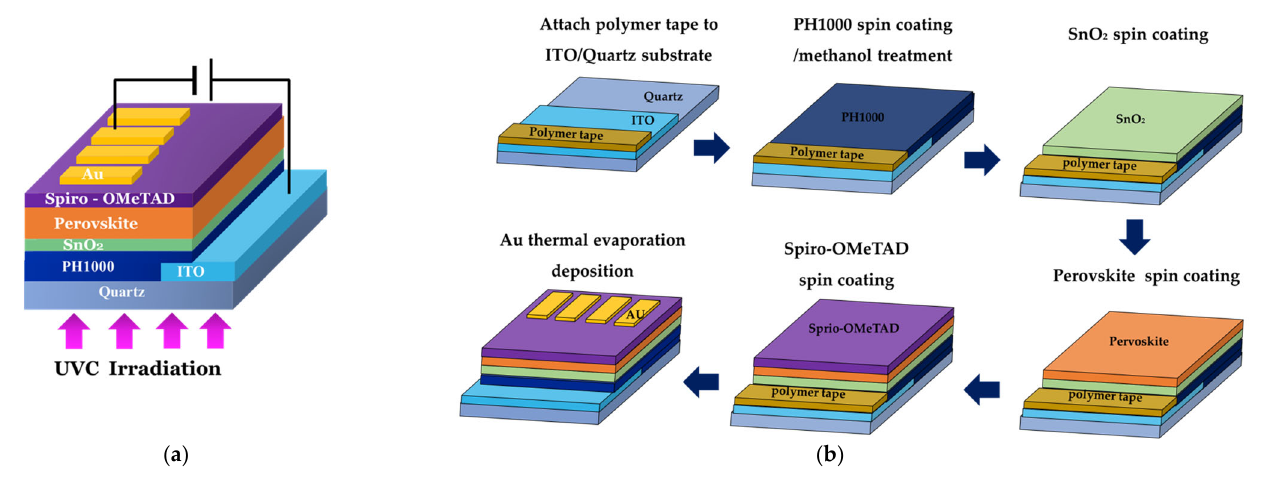
Figure 1. ( a ) Schematic showing the structure of the mixed cation ‐ based n ‐ i ‐ p UVC photodetector. ( b ) The fabrication process for the detector.